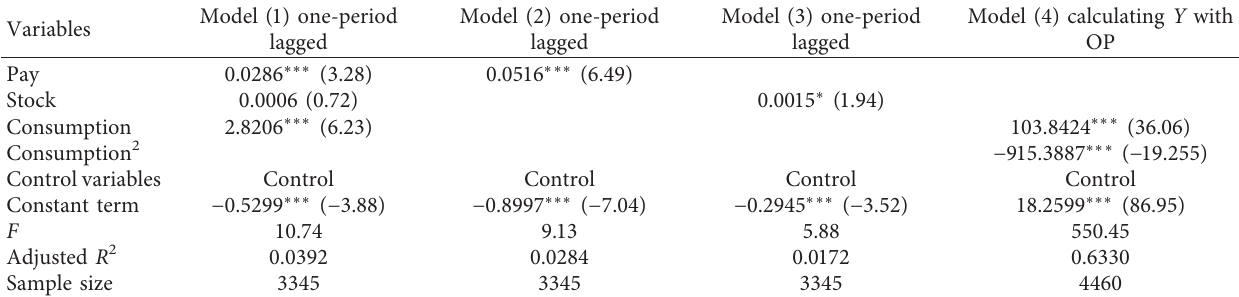
Table 7: Robustness